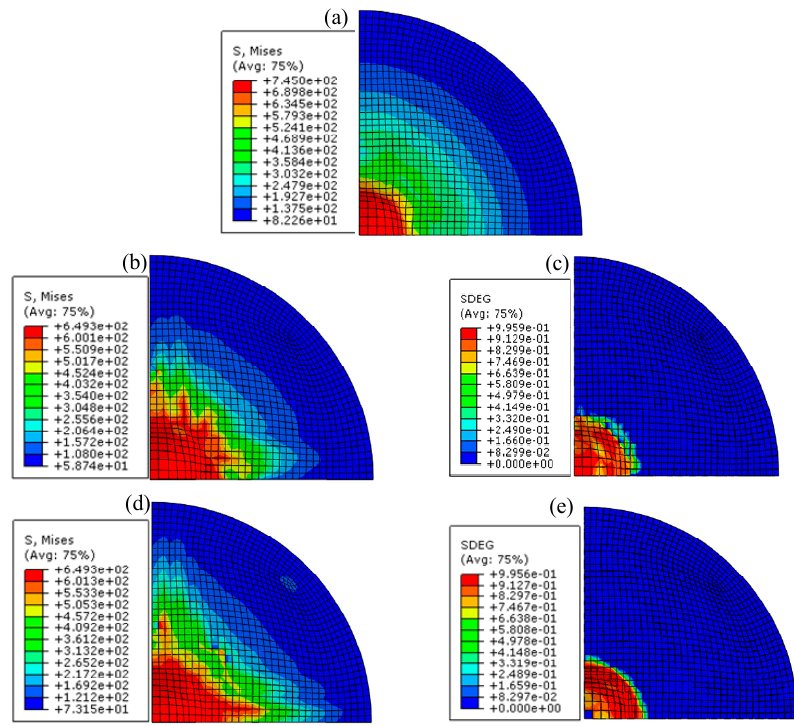
Figure 15. Numerical simulation results of the drawing of the five-layers model under blank holder force 50 kN and punch stroke 9.76 mm: ( a ) Substrate, ( b ) Upper coating layer (contact with the die), ( c ) Upper cohesive layer, ( d ) Lower coating layer (contact with the blank holder and punch), ( e ) Lower cohesive layer.